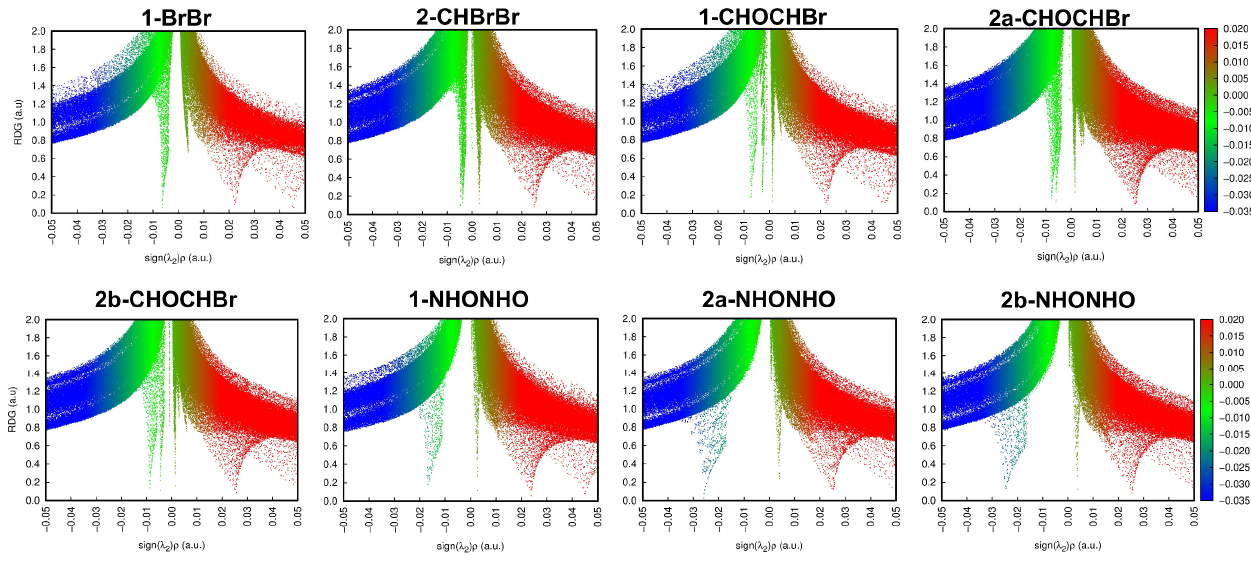
Figure 7. Scatter graph of RDG. Points in the blue region, where sign ( λ 2 ) ρ assumes negative values, are indicative of strong attractive interactions such as a hydrogen bond. Points in the green region, for values of sign ( λ 2 ) ρ close to zero, are indicative of van der Waals contacts. Points in the red region, where sign ( λ 2 ) ρ assumes positive values, are indicative of repulsive effects. These results were obtained with the MP2/def2-TZVP theory level.